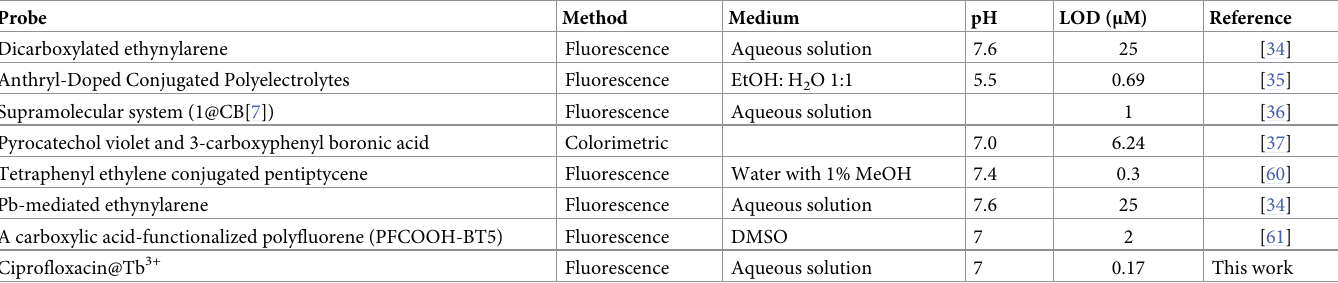
Table 1. Comparison of various analytical methods for spermine detection.